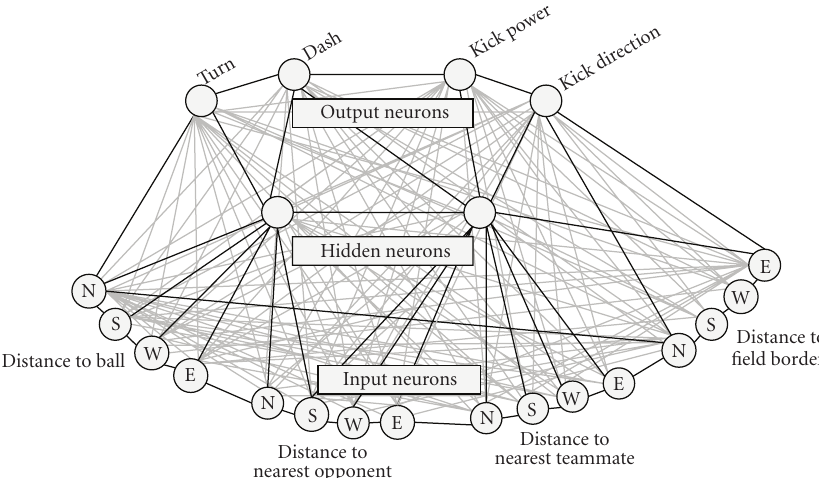
Figure 2: A possible wiring of the neural network showing the groups of inputs, outputs and hidden neurons. Connections with stronger weight are indicated with bold lines while ones with lower weight are colored with grey.